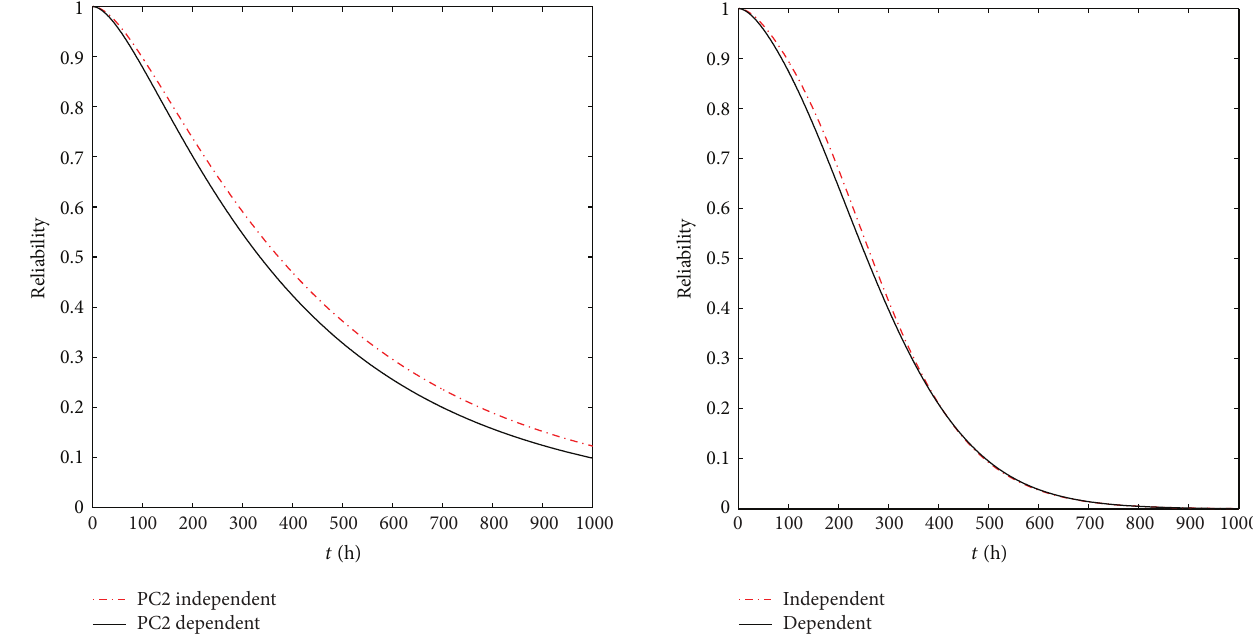
Figure 2: Marginal reliability curves of PC2. Figure 3: Reliability curves of system based on dependent and independent